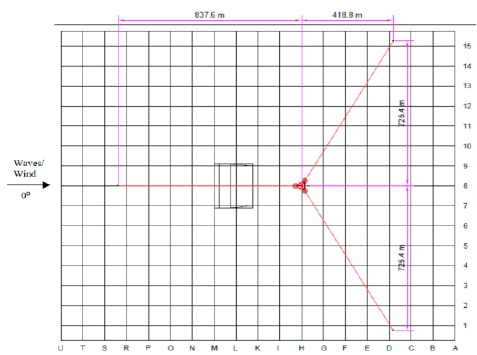
Figure 11. Common mooring method of the semi-wind turbine platform.